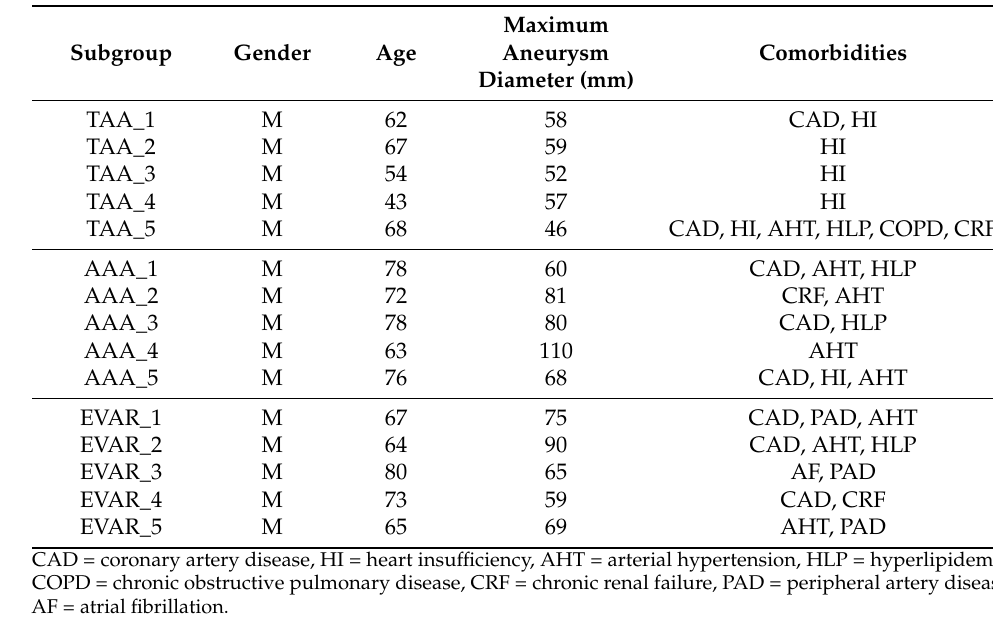
Table 1. Indications and patient characteristics.